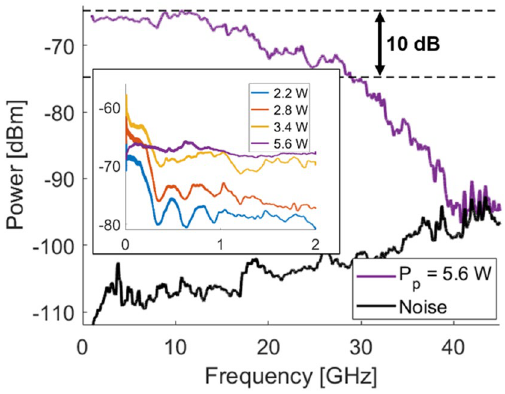
Figure 5. RF Spectra of the random laser over a 45 GHz span at a 5.6 W pump power. The inset shows the various peaks observed at lower pump powers, while as pump power is increased, the spectrum flatness is also